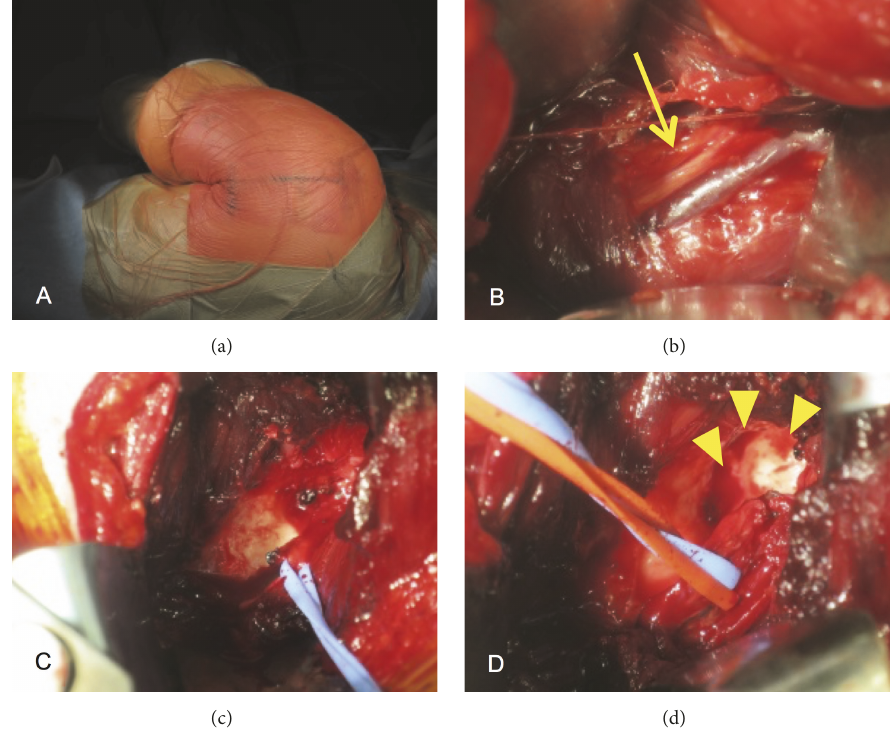
Figure 3: (a) Surgery for the intraosseous ganglion is performed in the right lateral position. A 10cm skin incision is made at the posterior glenohumeral joint. (b) Intraoperative photograph of the posterior shoulder shows the suprascapular nerve after splitting the infraspinatus (yellow arrow). (c) Intraoperative photograph shows a mucinous cyst wall after shifting the suprascapular nerve laterally. (d) Intraoperative photograph shows the bone cavity of the glenoid after curettage of the cyst (yellow arrowheads).